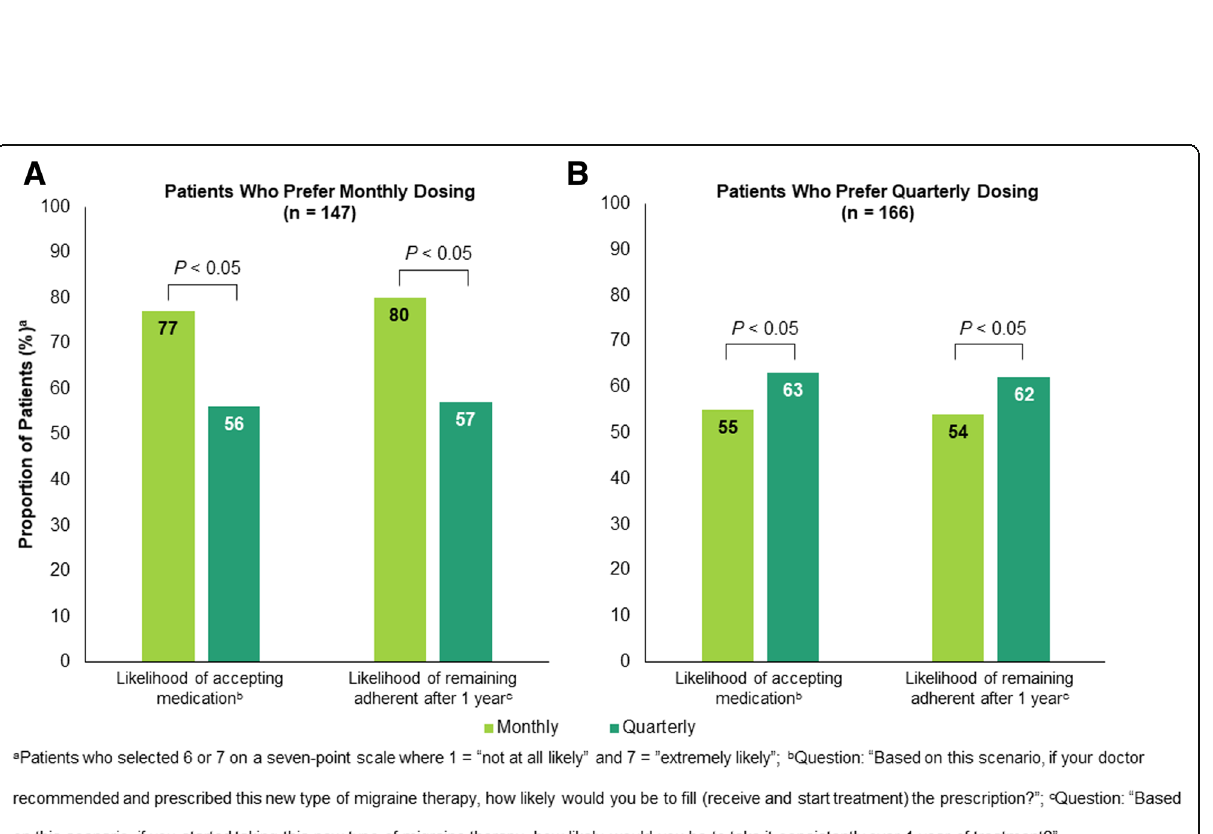
Fig. 6 Likelihood of acceptance of and adherence to the new medication based on dosing preference and